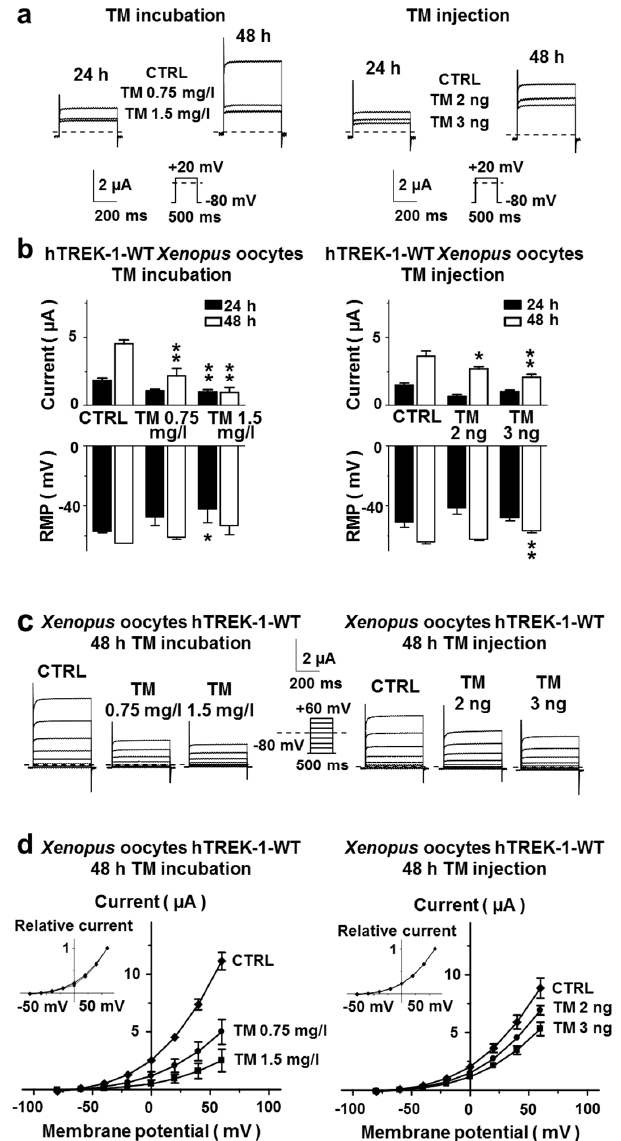
Figure 2. Inhibition of N -glycosylation by tunicamycin decreases TREK-1 currents. ( a ) The TREK-1 currents elicited by a 500 ms depolarizing voltage step from − 80 mV to +20 mV (see depicted pulse protocol) are displayed under control conditions (CTRL) and 48 h after administration of TM by incubation (left) or cytoplasmic injection (right). Representative recording of n = 6–12 cells. ( b ) The mean potassium currents at +20 mV (top) and the resting membrane potentials (RMPs, bottom) are provided for different time points (24 h, black bars; 48 h, white bars) after TM incubation (left; n = 3–15) or cytoplasmic injection (right; n = 3–15 cells). ( c ) Representative families of macroscopic hTREK-1 potassium currents recorded from Xenopus laevis oocytes by application of the depicted pulse protocol. ( d ) Corresponding mean step current amplitudes plotted as functions of the test pulse potential showing comparable current-voltage relationships under control conditions and after application of TM. Inserts: the data are presented relative to the maximum current amplitude measured at +60 mV. The data are given as the mean ± standard error of the mean (SEM). The zero-current levels are indicated by dashed lines. The pulse protocols are depicted below the respective current traces. * p < 0.05, ** p < 0.01.